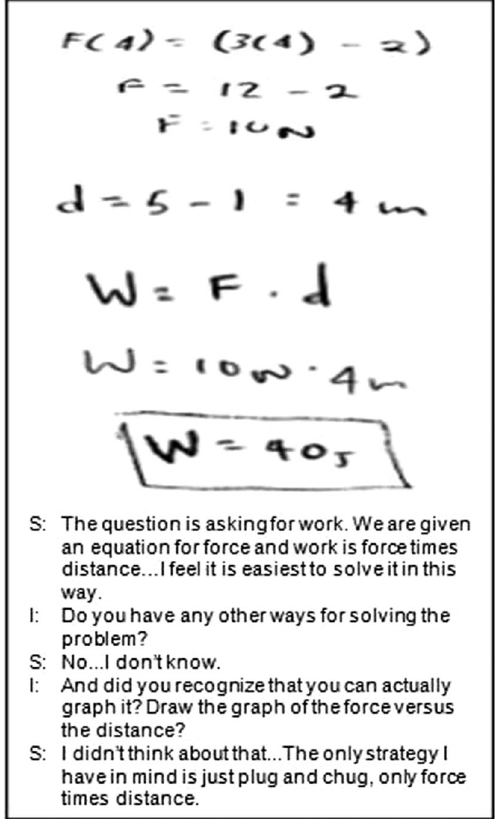
FIG. 16. Solvevalue from symbolic representation (question 8).